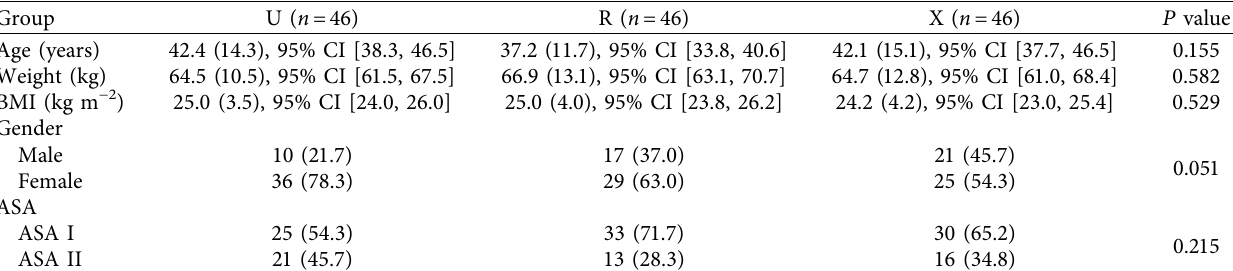
Figure 2: CONSORT fowchart. Table 1: Demographic